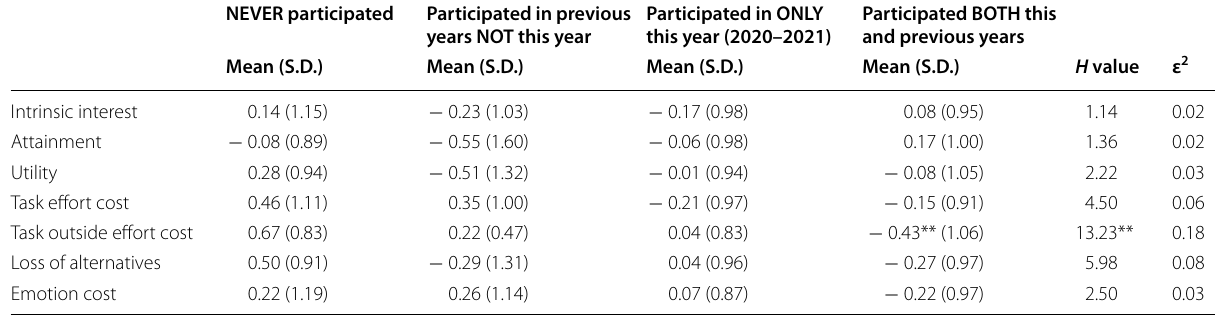
Pairwise comparisons are reported. The reference group is “students who never participated in co-curriculars